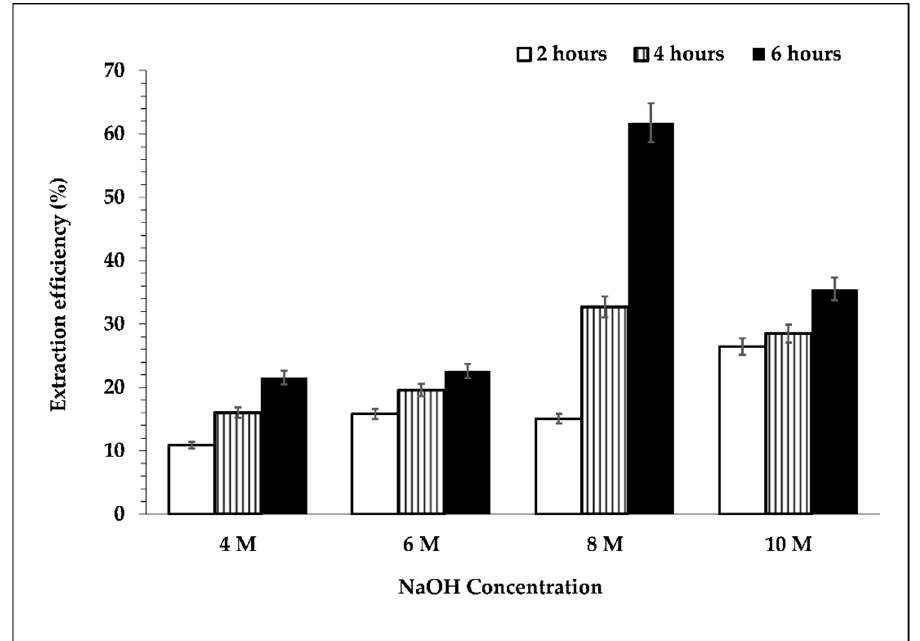
Figure 3. Effect of NaOH concentration and leaching time on the extraction efficiency of silicon. Leaching process was performed at temperature of 95 °C, s/L ratio 1/10, and 300 rpm.